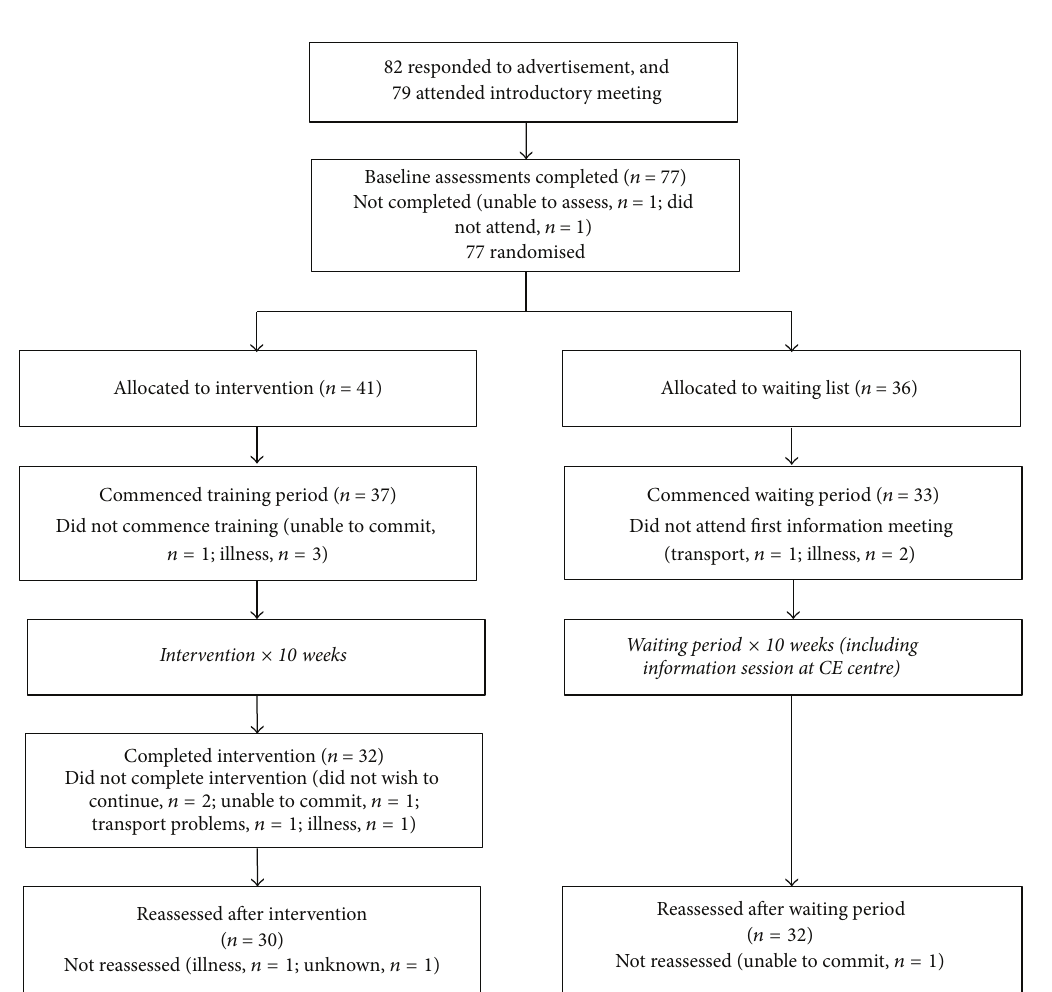
Figure 1: Flow of participants through the study: numbers completing each stage and reasons for